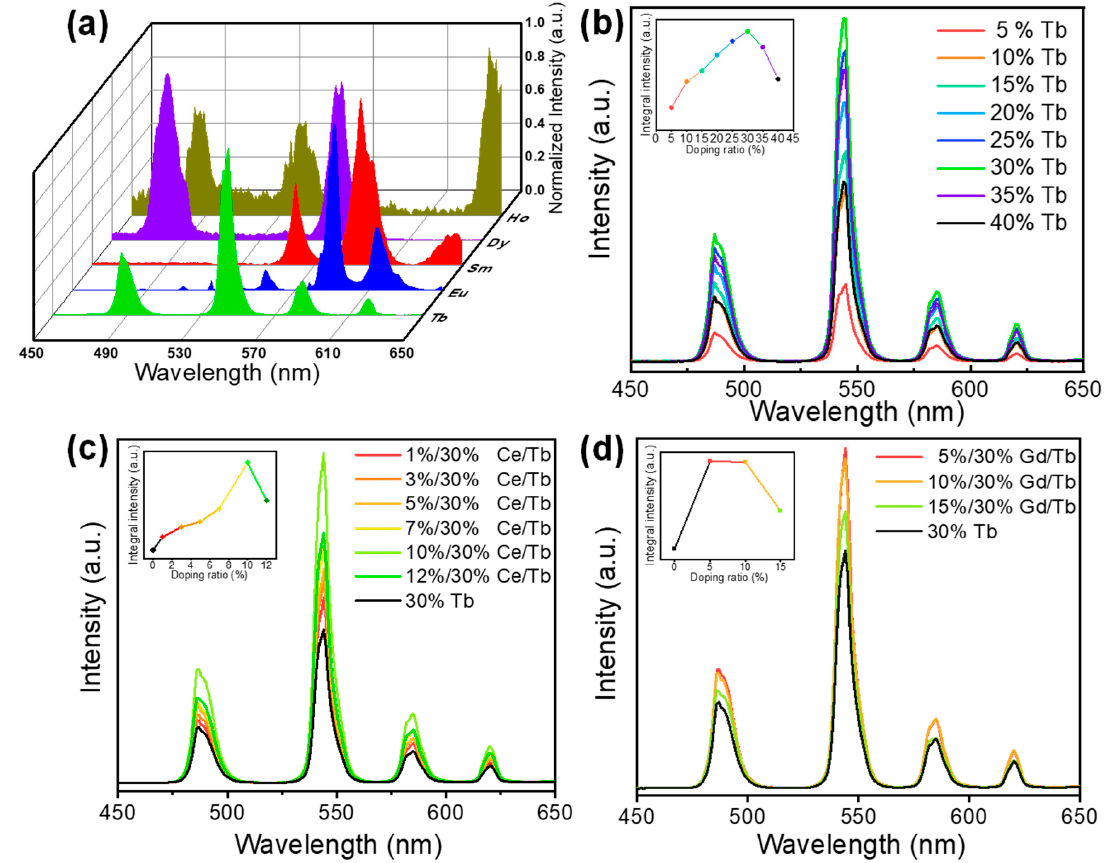
Figure 3. ( a ) Normalization scintillation spectra of the Pb 4 Lu 3 F 17 : Re 3+ (Re = Tb, Eu, Sm, Dy, Ho). ( b ) Scintillation spectra of Pb 4 Lu 3 F 17 : Tb with different Tb 3+ doping concentrations (x = 5, 10, 15, 20, 25, 30, 35, 40 mol%). ( c ) Scintillation spectra of the Pb 4 Lu 3 F 17 : 30Tb/yCe (y = 1, 3, 5, 7, 10, 12 mol%). ( d ) Scintillation spectra of the Pb 4 Lu 3 F 17 : 30Tb/yGd (y= 5, 10, 15 mol%).